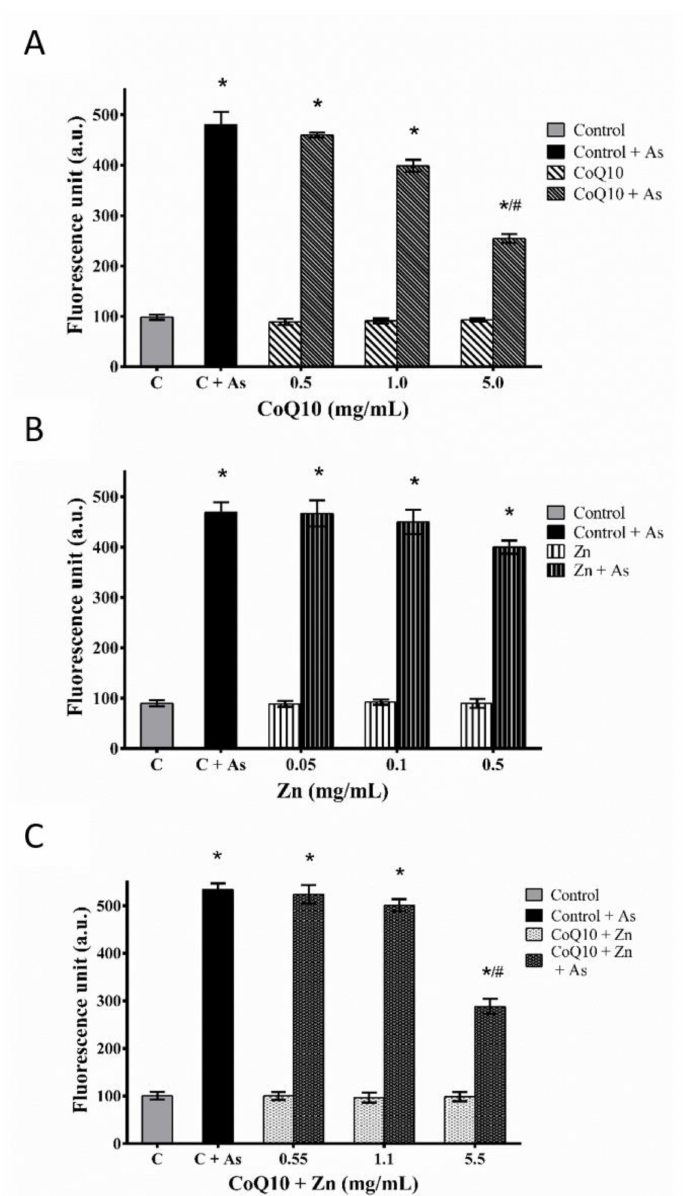
Figure 7. Protective effect of CoQ10 ( A ), Zn ( B ) and CoQ10 + Zn ( C ) pretreatment against As-induced oxidative stress in CHO-K1 cells. The CHO-K1 cells were exposed to 5 ppm of As for 24 h with or without test compounds pretreatment. ROS generation was measured by the DCFH-DA method using a multidetection reader and fluorescence microscope at 100 × magnification. Statistical analysis was performed by one-way ANOVA test, followed by Tukey’s post-hoc test. The results are expressed as the means ± SEM of three independent experiments. * ( p < 0.05) versus the same compound group without As, # ( p < 0.05) versus between groups with